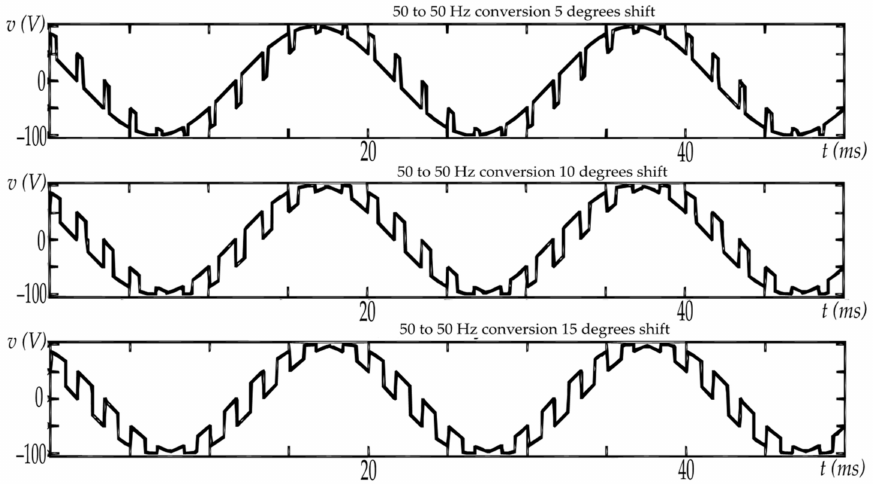
Figure 9. Output voltage for 12 × 12 MMC for the “two closest” control areas for 50-to-50 Hz conversion and 5 ◦ , 10 ◦ , and 15 ◦ shifts.